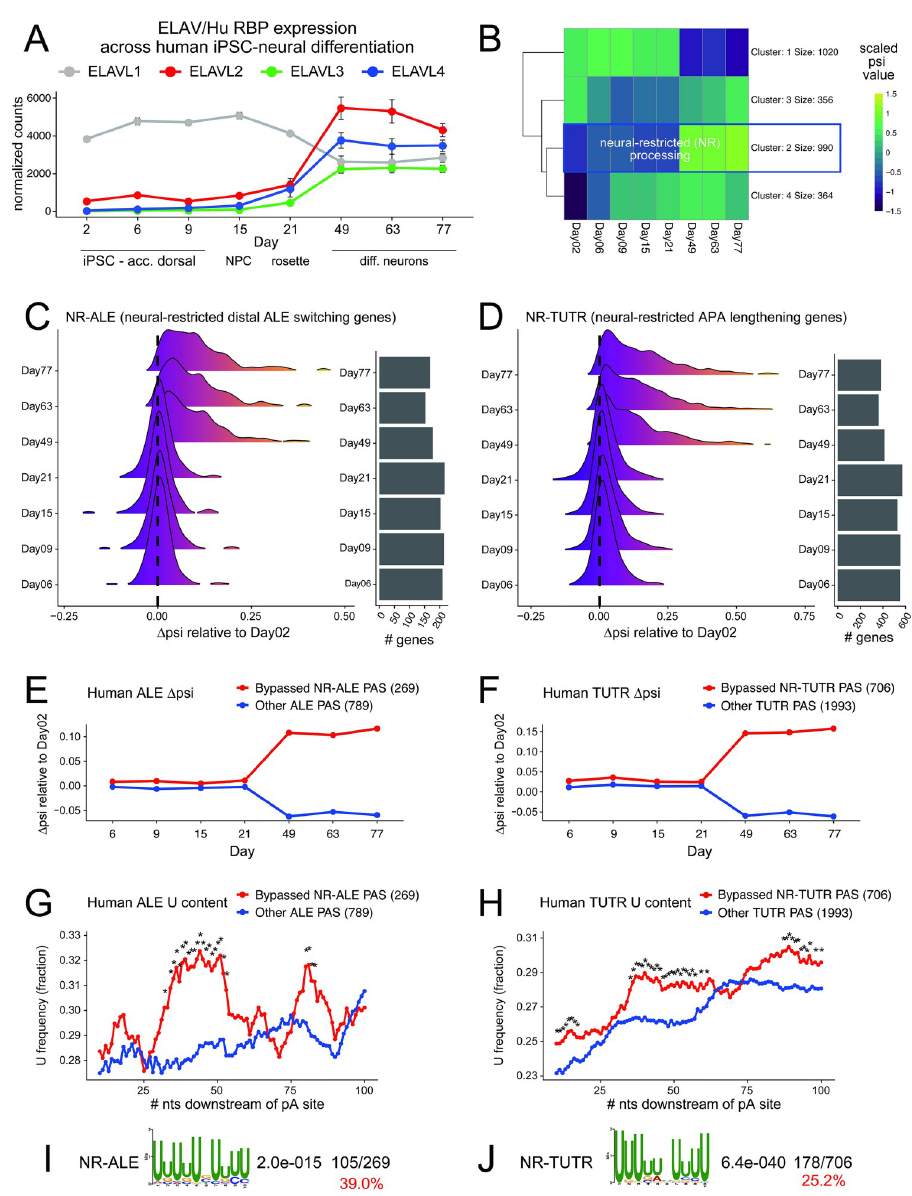
Fig 8. Evidence that mammalian neural ELAV/Hu RBPs are involved in distal ALE switching and 3’ UTR lengthening in neurons. (A) Expression of ELAV/Hu RBP members across a timecourse of directed differentiation of human iPSCs into neurons [64]. ELAVL1 (HuR) is ubiquitous and is downregulated upon neuronal specification, while ELAVL2-4 (HuB-D) are upregulated upon neuronal commitment. (B) K-means clustering identifies a cohort of genes with monotonically increasing ψ across the neuronal differentiation timecourse, i.e. genes with neural-restricted (NR) alternative processing. (C-D) Collective behavior of NR-ALE (C) and NR-APA (D) genes across the neuronal differentiation timecourse. (E-F) Average behavior of NR-ALE (E) and NR-APA (F) genes across the neuronal differentiation timecourse. (G-H) Both NR-ALE (G) and NR-APA (H) genes specifically exhibit enrichment of uridine downstream of polyadenylation (pA) sites that are bypassed in neurons, compared to pA sites in other ALE and TUTR genes expressed in neurons. (I-J) The 100 nt regions downstream of NR-ALE (I) and NR-TUTR pA sites bypassed in neurons are highly enriched for ELAV/Hu RBP binding